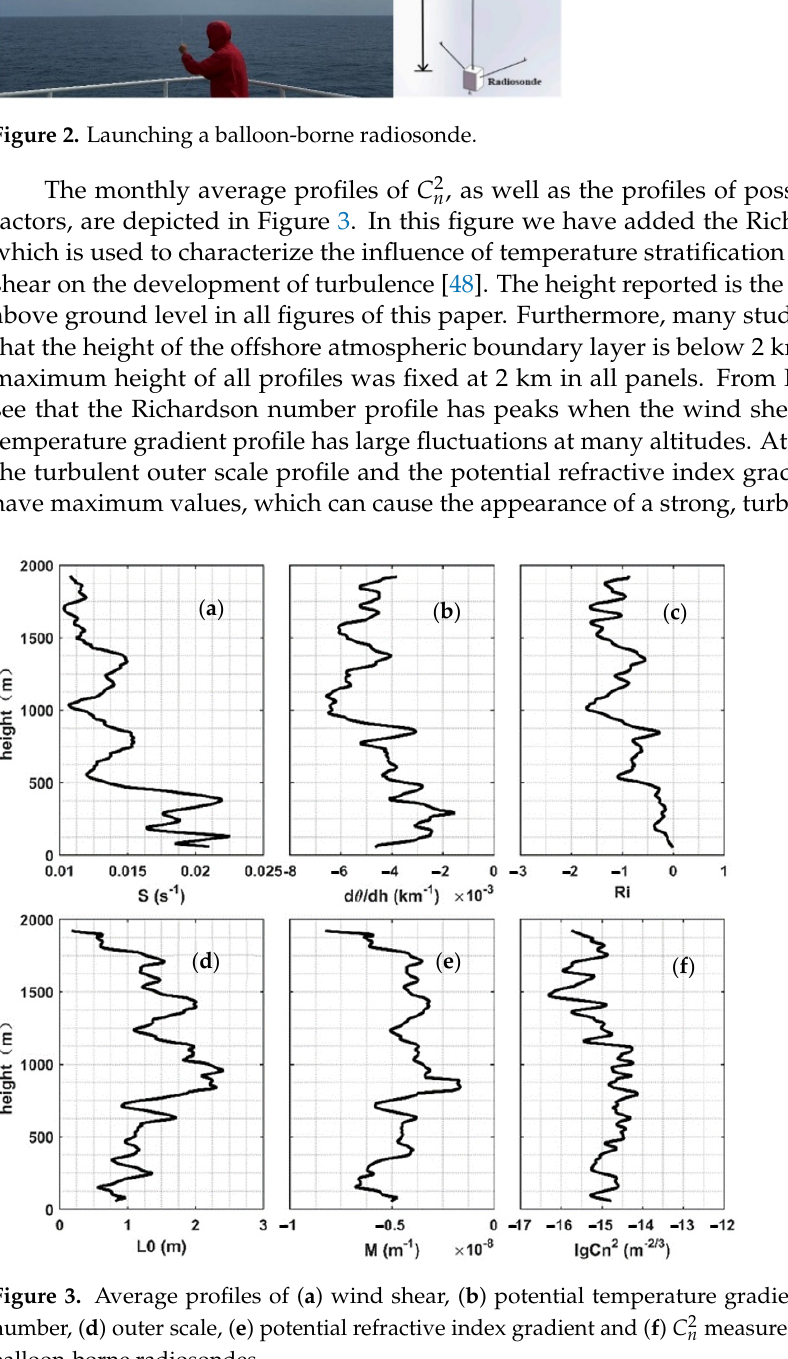
C measured by all samples n